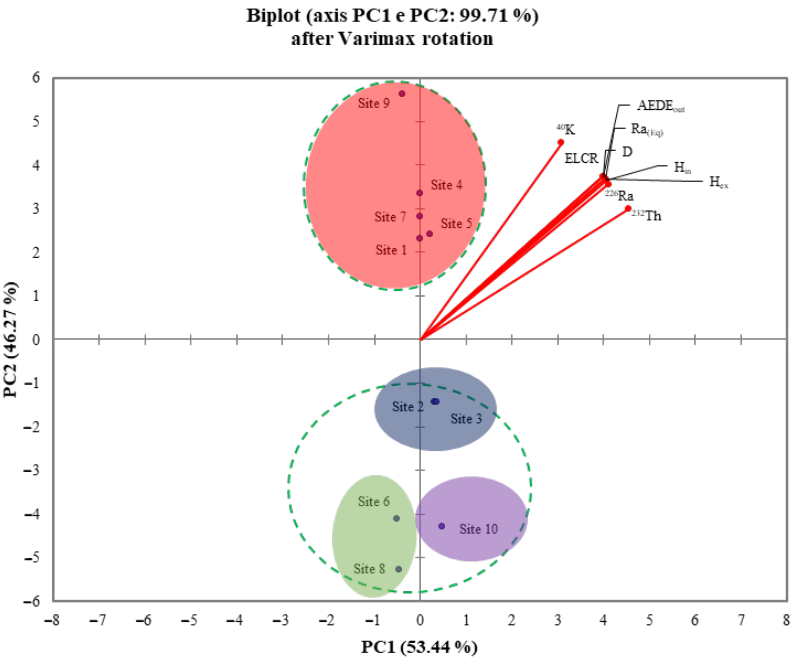
Figure 7. PCA loading plot.